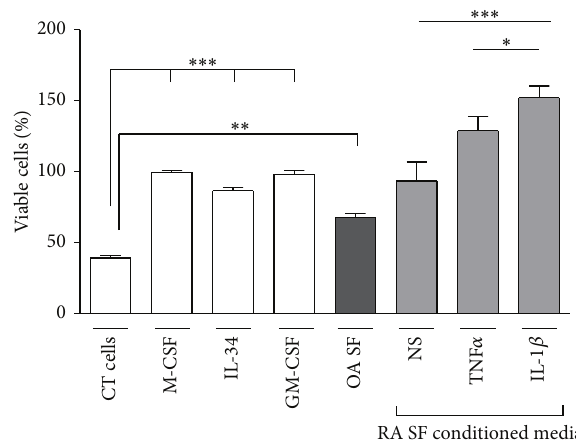
Figure 1: SF conditioned media promote monocyte viability . CD14+ cells were cultured 3 days in presence of medium alone (control (CT) cells), M-CSF, IL-34, GM-CSF, or conditioned media from RA SF stimulated or not (NS) with TNF 𝛼 or IL-1 𝛽 for 24 hours and from not stimulated OA SF. Monocyte viability was evaluated by colorimetric assay (WST-1). Results are given as the percentage of viability induced by M-CSF (100%) ( 𝑛 = 9 patients for RA and 2 patients for OA). ∗ 𝑃 < 0.05 ; ∗∗ 𝑃 < 0.001 ; ∗∗∗ 𝑃 < 0.0001